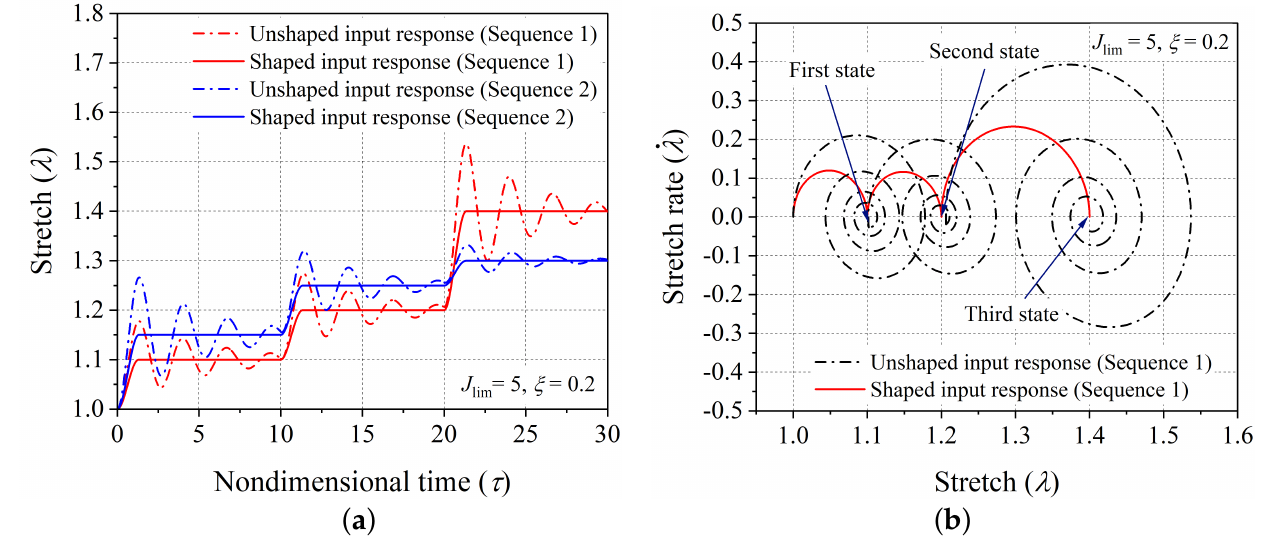
Figure 5. ( a ) Controlled and uncontrolled transient response for the two desired equilibrium se- quences ((1.10, 10), (1.20, 10), (1.40, 10)) and ((1.15, 10), (1.25, 10), (1.35, 10)) of the hard-magnetic soft actuator, and ( b ) controlled and uncontrolled phase-plane portraits for the desired equilibrium sequence ((1.10, 10), (1.20, 10), (1.40, 10)).